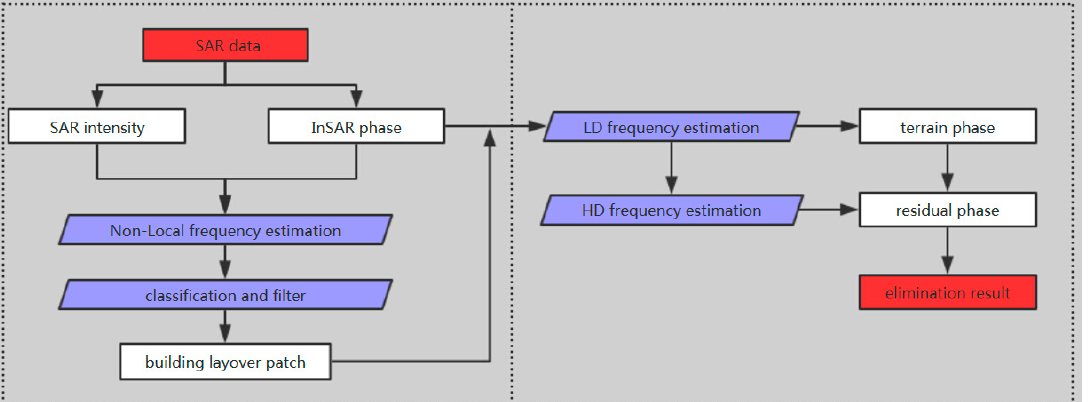
Figure 5. Workflow of the proposed method.